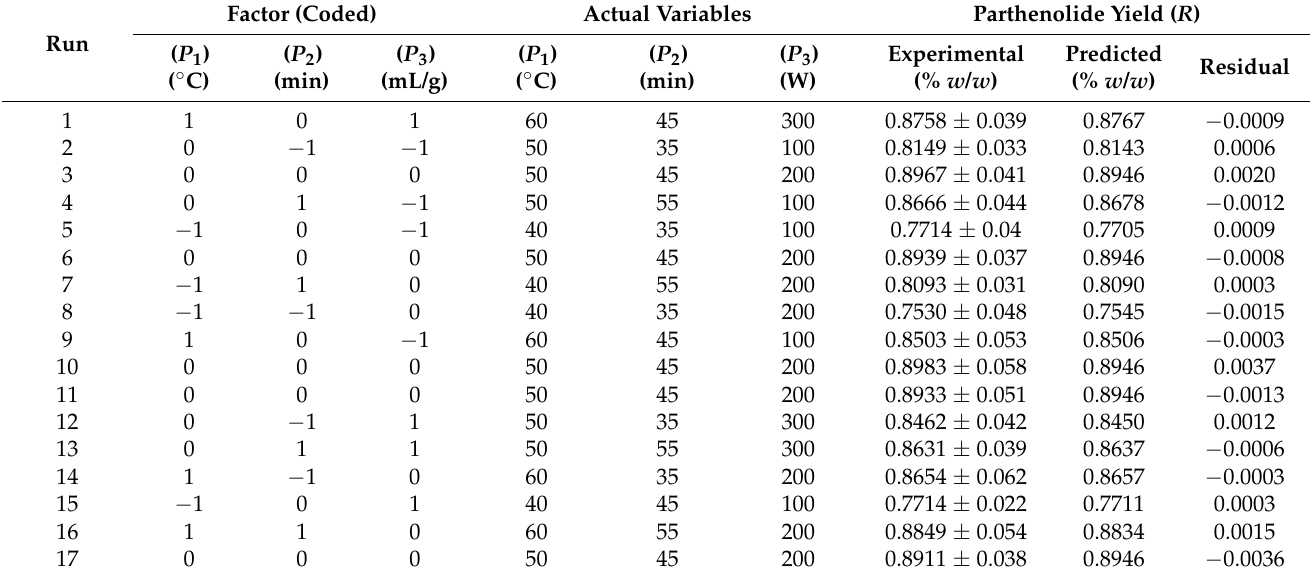
Table 2. Experimental parameters of Box–Behnken design and result of R